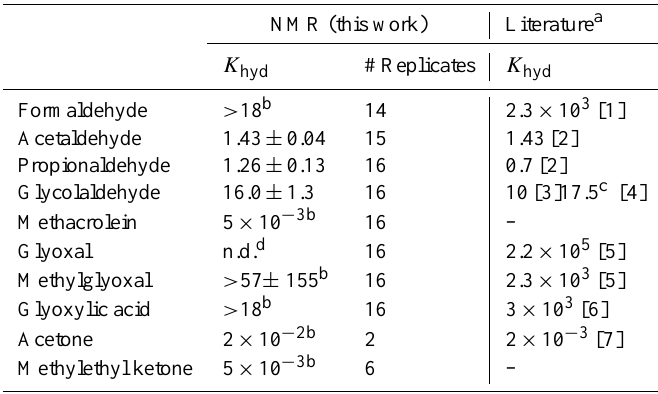
Table 1. Summary of hydration equilibrium constants ( K hyd ) measured by NMR. The constants are reported with their standard deviation arising from the number of replicates indicated in the table.